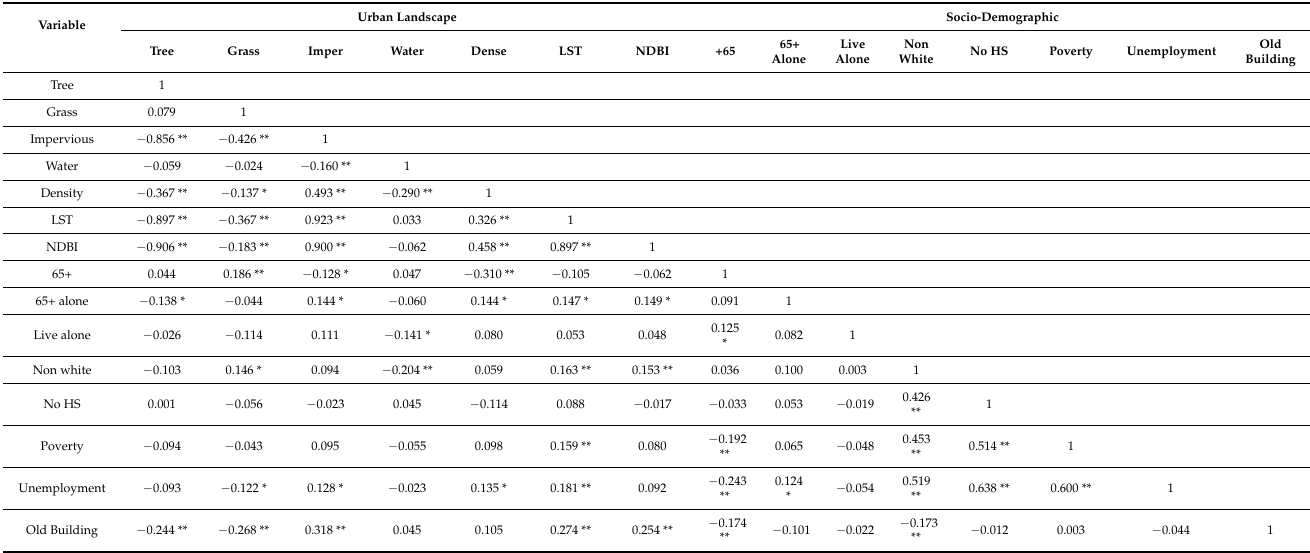
Table 1. Descriptive Statistics for census block group variables.